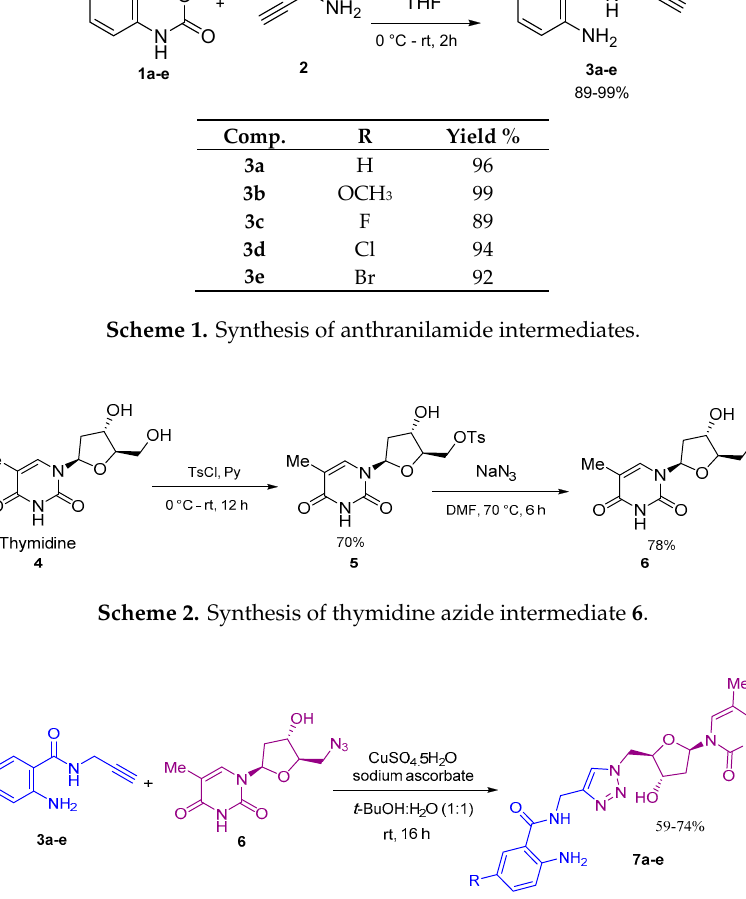
Figure 4. Ligand-based design of novel PqsA